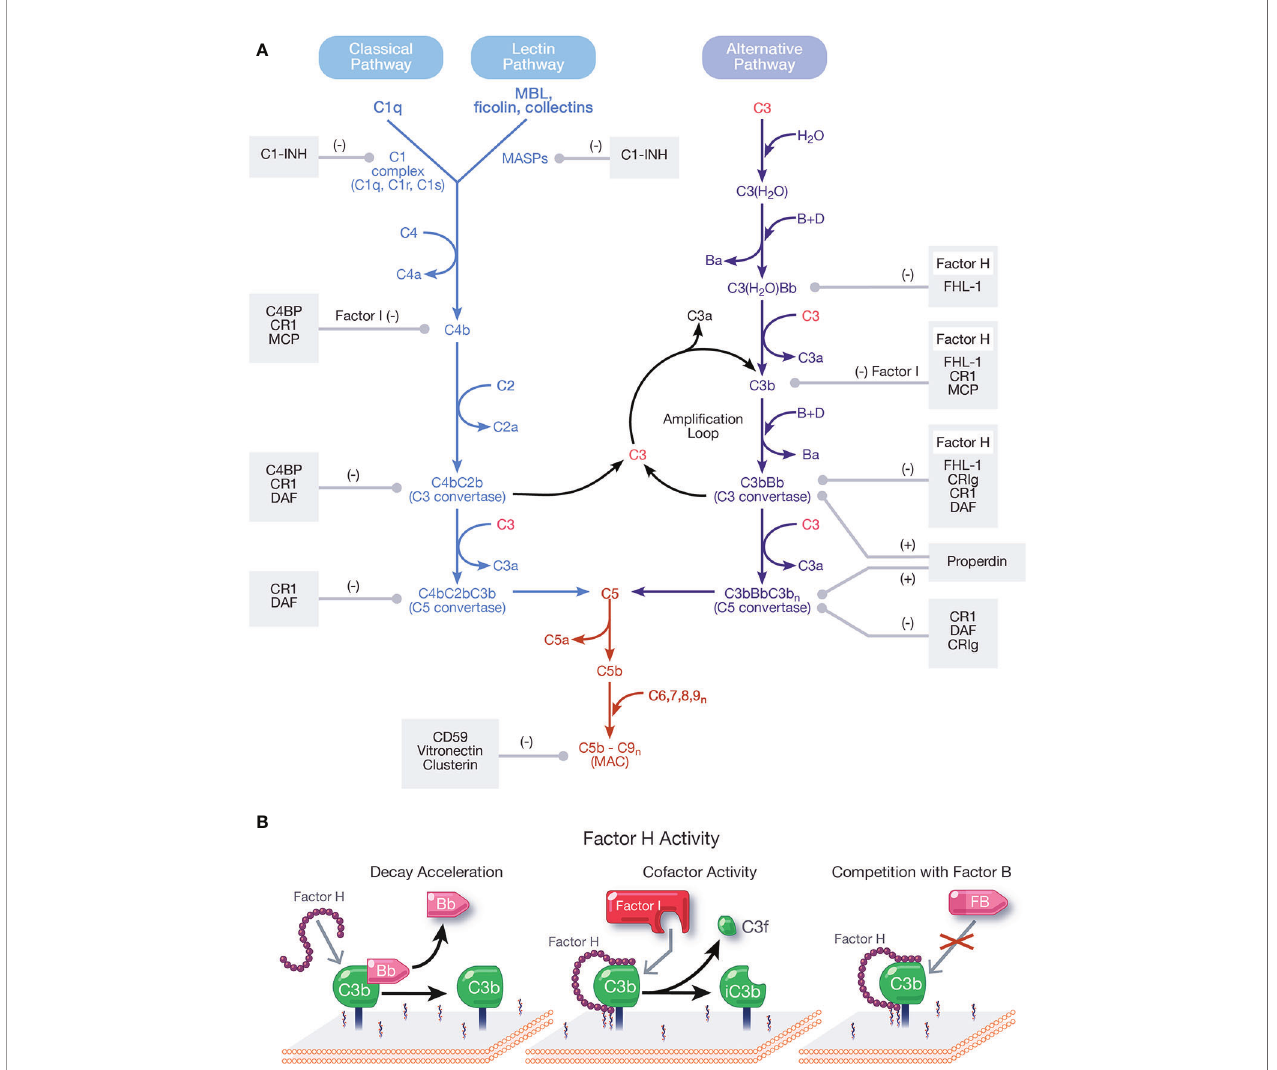
FIGURE 1 | Overview and regulation of the complement system. (A) Complement is activated by three pathways: the classical, lectin, and alternative pathways. The classical pathway (CP) activates when the C1 complex (C1q, C1r, C1s) recognizes and binds pathogen- or cell-bound immunoglobulins, circulating immune complexes, or pentraxins. The lectin pathway (LP) activates when mannose-binding lectin (MBL) fi colins, or collectins recognize molecular patterns such as carbohydrates and other ligands on foreign surfaces. CP and LP activation results in cleavage of C4, followed by cleavage of C2, forming the CP/LP surface bound C3 convertase, C4bC2b. The alternative pathway (AP) is spontaneously activated when soluble C3 hydrolyzes to C3(H 2 O). C3(H 2 O) can bind FB (labeled B) and recruit Factor D (labeled D) which cleaves FB to Bb (and Ba), resulting in the fl uid phase AP C3 convertase, C3(H 2 O)Bb. C3(H 2 O)Bb cleaves C3 to C3a and C3b. C3b then binds covalently to nearby surfaces to form membrane-bound C3 convertase, C3bBb. C3 convertases derived from all pathways cleave C3 to C3a and C3b. C3b combines with formed C3 convertases to form the CP/LP C5 convertase (C4bC2bC3b) and AP C5 convertase (C3bBbC3b n ). C5 is cleaved by C5 convertases to initiate the common, terminal pathway, which culminates in the formation of the membrane attack complex (MAC). C3b produced from the cleavage of C3 by C3 convertases from all pathways forms an ampli fi cation loop that contributes to the generation of additional AP C3 convertases. Positive (labeled +) and negative (labeled − ) regulators of all complement pathways are shown. Membrane-bound complement negative regulators include complement receptor 1 (CR1/ CD35), decay accelerating factor (DAF/CD55), membrane cofactor protein (MCP/CD46), CD59, and complement receptor of the immunoglobulin family (CRIg). Soluble negative regulators include Factor H (FH), FI, C4 binding protein (C4BP), C1 inhibitor (C1-INH), clusterin, vitronectin, and Factor-H like protein 1 (FHL-1). Positive regulators of complement include FH-related proteins (FHRs) -1, -4, and -5, and properdin. (B) Function of FH. FH accelerates the decay of AP C3 convertase by dissociating Bb (decay acceleration function); acts as a cofactor for Factor I-mediated cleavage of C3b into iC3b, an inactivated form that does not allow complement activity to progress (cofactor activity function); and competes with FB for binding to C3b to form the AP C3